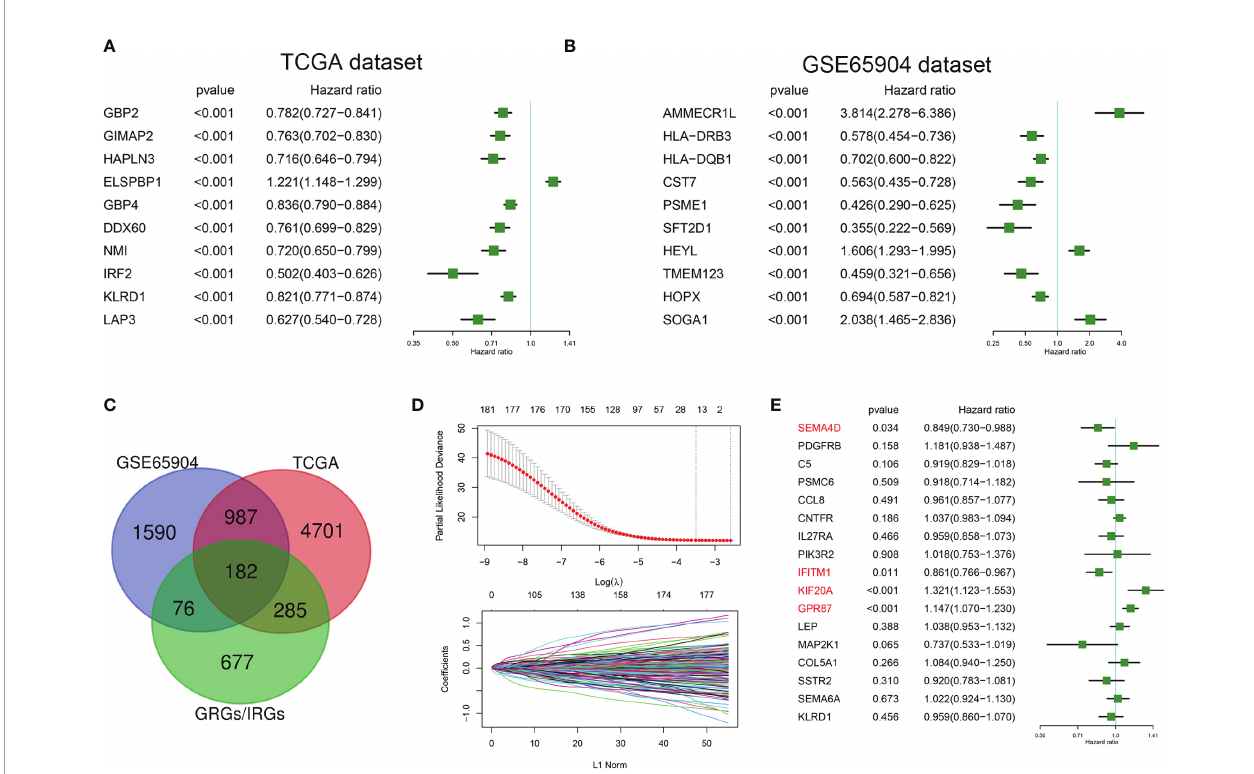
FIGURE 1 | Identi fi cation of prognostic GRGs and IRGs in melanoma. Forest plots showing hazard ratios of the top 10 genes(sorted by p value) from the (A) TCGA and (B) GSE65904 datasets. (C) Venn diagram indicating that 182 prognostic GRGs and IRGs were identi fi ed in the GSE14520 and TCGA cohorts. (D) Cross- validation (100-fold) for tuning parameter selection in the LASSO model (upper panel) and LASSO coef fi cient pro fi les of the most relevant prognostic genes (lower panel). (E) Results of the cox proportional hazards regression model based on 17